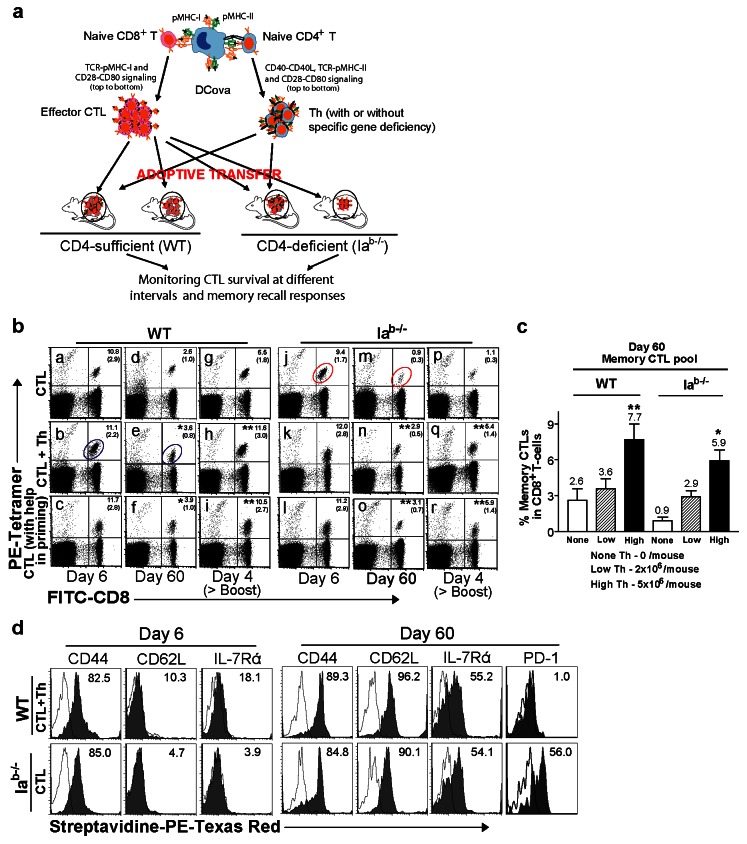
Th cell help provided during the priming or transitional period enhances effector CTL survival and transition to memory development.(a) Experimental Design. To determine direct impact of Th cells on effector CTL fates after priming, effector CTLs and Th cells with or without specific gene deficiency were adoptively transferred to WT or CD4+ T cell-deficient mice. All mice were monitored for CTL survival and memory CTL recall responses during the memory phase. Memory recall responses were assessed by boosting with DCova 60 days following the adoptive transfer or by challenging with highly metastasizing BL6-10OVA 100 days post-transfer. (b) Approximately 5x106 effector CTLs alone that received help during the priming period or 5x106 effectors CTLs without or with 2x106 Th cells (i.e. help after CTL priming) were i.v. transferred into WT or Iab-/- mice as indicated. Six and sixty days later, the transferred CTLs were monitored in the tetramer assay. On the 60th day, all the groups were boosted with 1x106 DCova and monitored for memory CTL expansion 4 days later. The values represent mean%±(SD) of tetramer+ (Ova-specific) CTLs in total CD8+ T cell population, and are cumulative of three independent experiments with three to five mice per group. * or **, p < 0.05 or 0.01, respectively, versus unhelped CTLs. (c) Influence of Th cell numbers on effector CTL survival and memory CTL development. Approximately 5x106 effector CTLs alone (none) or 5x106 effector CTLs together with 2x106 (low) or 5x106 (high) Th cells were adoptively transferred to WT or CD4+ T cell-deficient mice and assessed 60 days later in the peripheral blood by tetramer assay. The values represent mean%±SD of tetramer+ CTLs in total CD8+ T cell population, and are cumulative of two independent experiments with four to five mice per group. * or **, p < 0.05 or 0.01, respectively, versus the low Th cell dose. (d) Blood samples from WT mice transferred with effector CTLs and Th cells or from CD4-deficient mice transferred with effector CTLs alone were collected 6 and 60 days post-transfer, respectively. The samples were processed for tetramer staining along with staining with a panel of biotin-conjugated Abs specific for effector or memory markers, and streptavidin-PE-Texas Red and PE-Cy5. PE-tetramer-positive CD8+ T cells in the circles (panels b and e and panels j and m) from WT and Iab-/- mouse groups were further assessed for expression of memory CTL markers such as CD44, CD62L and IL-7R or inhibitory PD-1 molecule (histogram grey filled overlays), respectively. Irrelevant isotype-matched Abs were used as control (dotted thin lines). Value in each panel represents the percentages of positive staining cells versus the control. One representative of two independent experiments is shown.